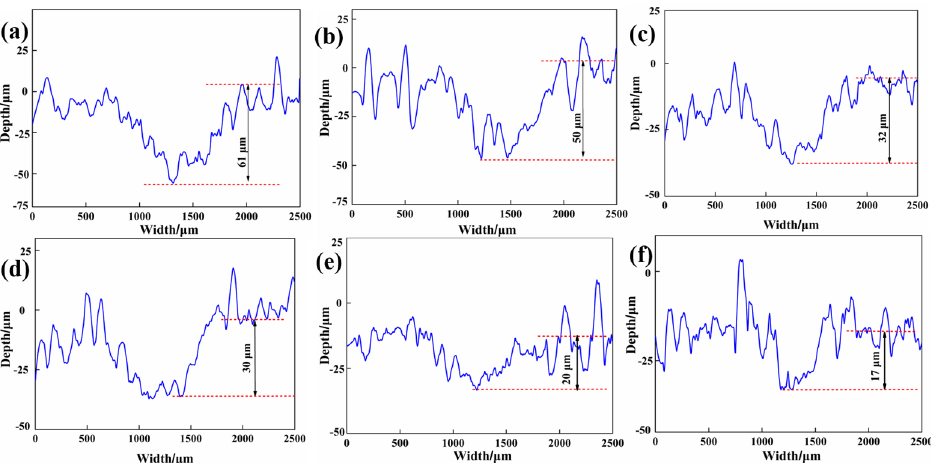
Figure 6. Wear track profiles of CFRP containing different contents of FGr@MoS 2 : ( a ) FGr@MoS 2 -0; ( b ) FGr@MoS 2 -0.3; ( c ) FGr@MoS 2 -0.6; ( d ) FGr@MoS 2 -0.9; ( e ) FGr@MoS 2 -1.2; ( f ) FGr@MoS 2 -1.5.